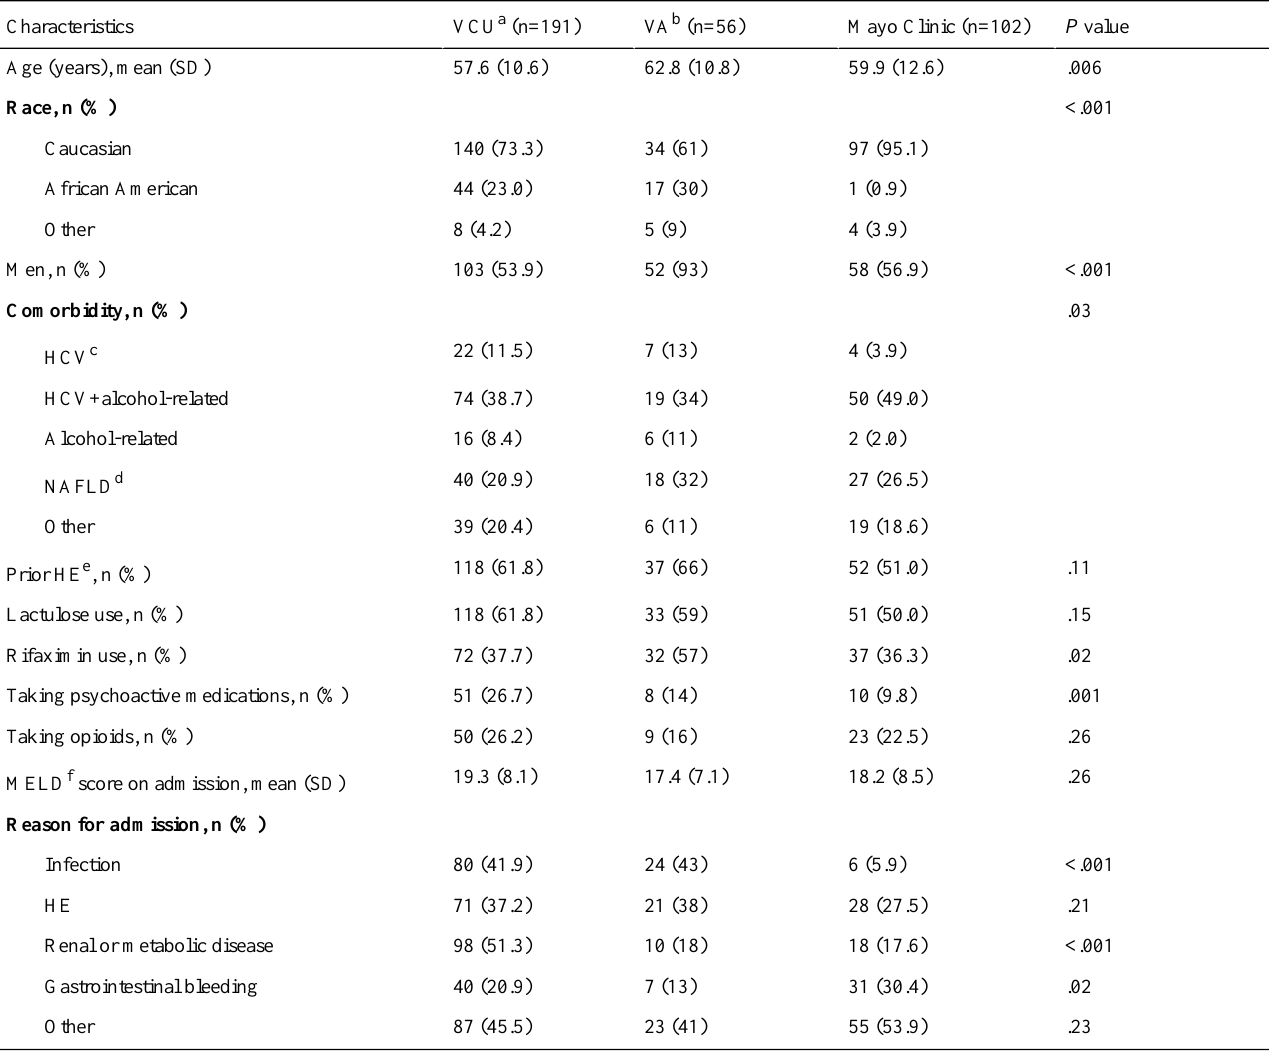
Table 4. Differences in patient characteristics among the three